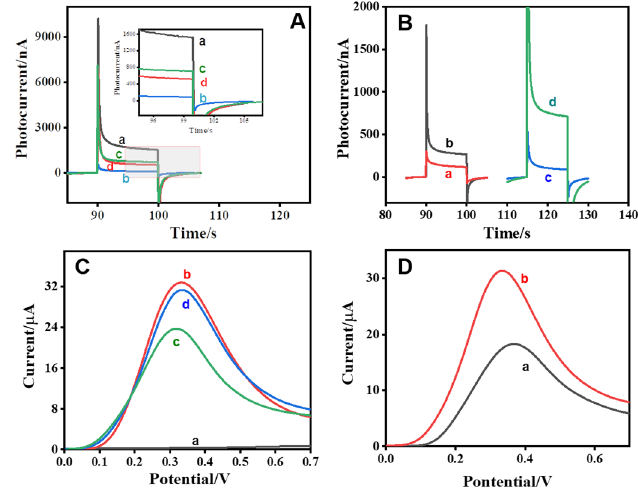
Figure 4. ( A ) Photocurrent response of the (a) Bi 2 S 3 /MXene, (b) MIP-CGA/Bi 2 S 3 /MXene, (c) MIP/Bi 2 S 3 /MXene and (d) MIP/ Bi 2 S 3 /MXene in presence of 2.825 × 10 − 7 M CGA; ( B ) Photocurrent response of (a,b) NIP/Bi 2 S 3 /MXene and (c,d) MIP/Bi 2 S 3 /MXene before (b,d) and after (a,c) CGA elution, respectively; ( C ) DPV response of (a) Bi 2 S 3 /MXene, (b) MIP-CGA/Bi 2 S 3 /MXene, (c) MIP/B Bi 2 S 3 /MXene and (d) MIP/Bi 2 S 3 /MXene in presence of 2.825 × 10 − 7 M CGA; ( D ) DPV response of (a) FTO and (b) Bi 2 S 3 /MXene/FTO in presence of 2.825 × 10 − 7 M